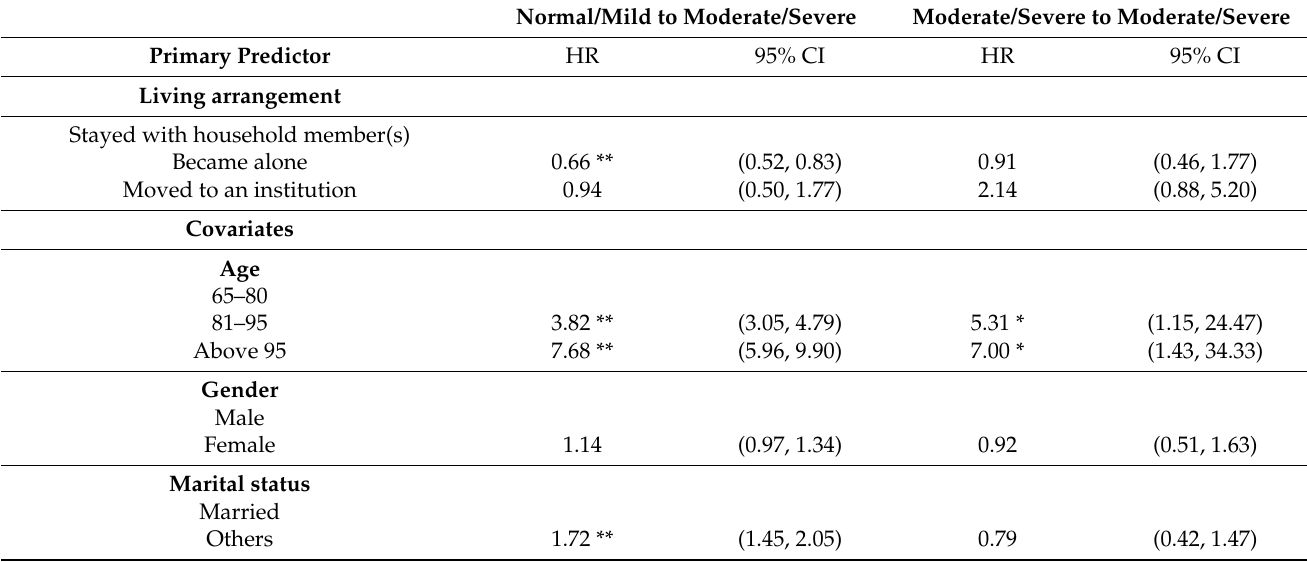
Table 2. Results of the association between living arrangement transition and changes of cognitive function among Chinese older adults, estimated by the multistate Cox regression model: the Chinese Longitudinal Healthy Longevity Survey,